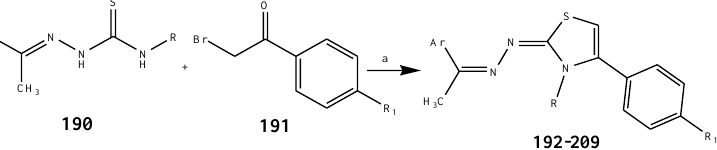
Scheme 14. (Thiazol-2-yl)pyrazol-5-amines from pyrazolylthioureas and ω